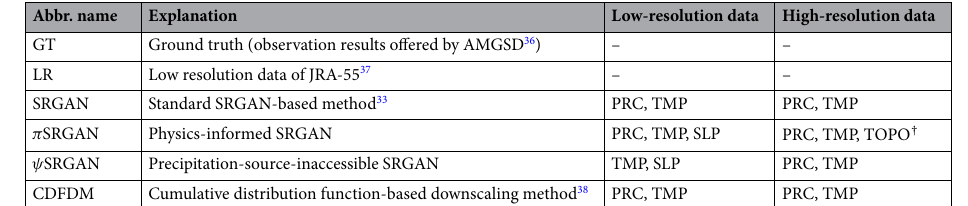
Table 1. Summary of protocols compared in this study. PRC precipitation, TMP temperature, SLP sea level pressure, TOPO topography. † In π SRGAN, TOPO is used as a hint, not